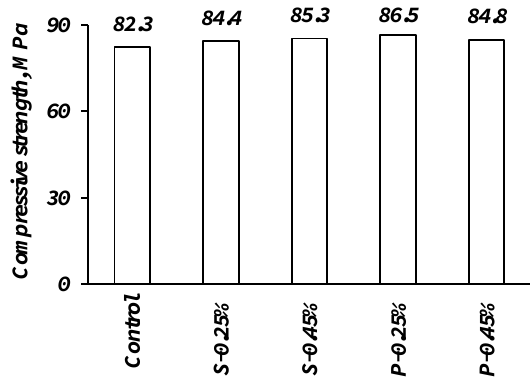
Figure 6. Effect of fibers on the compressive strength.